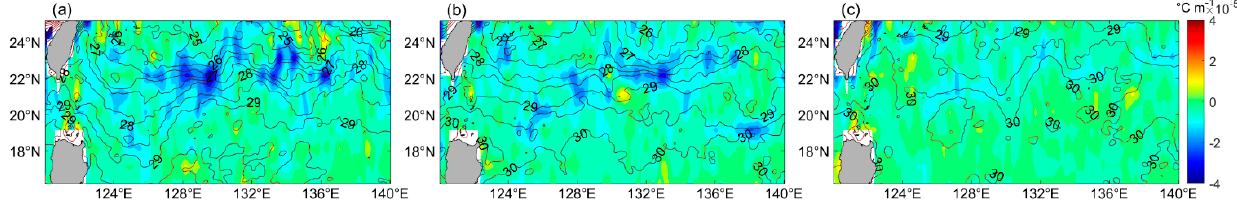
Figure 9. Spatial distribution of meridional SST gradient (color shaded) and SST (contours, units in °C) during ( a ) May, ( b ) June, and ( c ) July 2010, based on the OISST product gridded at 0.05°. Overall, the subtropical front was represented by large meridional SST gradients that tilt slightly at a southwest–northeast orientation within 20° N and 25° N, consistent with the northernmost subtropical front reported by Kobashi et al. [15], who focused on the long-term mean of three subtropical fronts in the NPSG. Large meridional SST gradients could also be observed near the KC east of the Luzon Strait in May and June (Figure 9a,b),